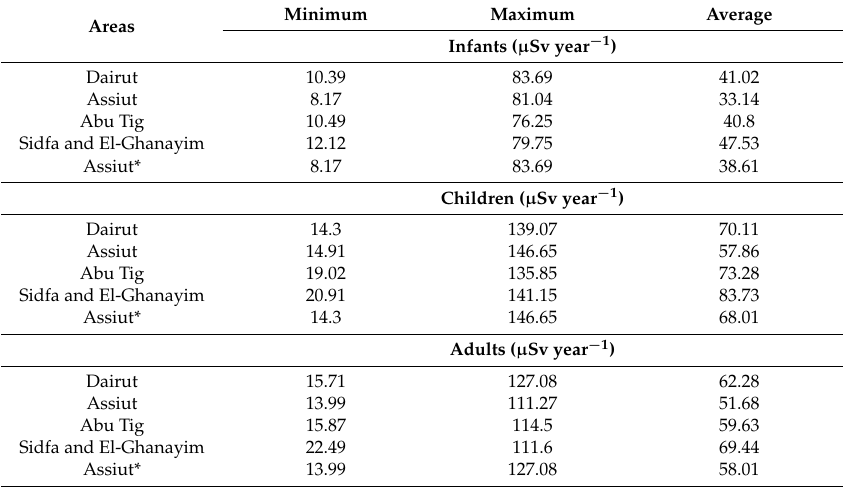
Table 4. The ranges and average estimations of the total annual effective doses for infants, children, and adults for water samples.